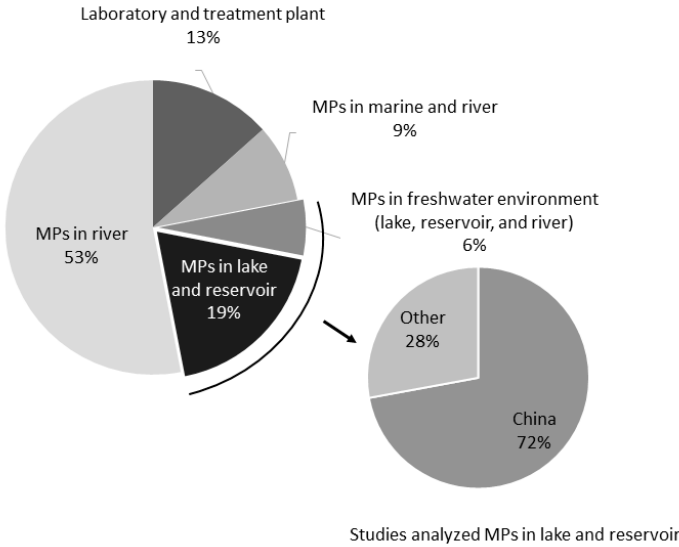
Figure 7. Water systems focused on by the selected studies.